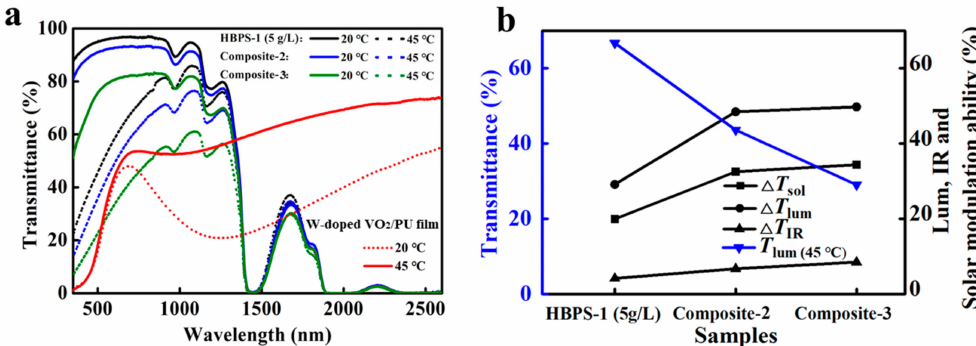
Figure 7. ( a ) UV-vis near-IR spectra of films of W-doped VO 2 (M) / PU with 2-3 µ m thickness (red solid and dashed lines), HBPS-1 (5 g / L), Composite 1 and Composite 2 at 20 and 45 ◦ C; ( b ) Changes of T lum , ∆ T ∆ T ∆ T / L), Composite 2, and Composite 3. sol , IR , and lum for films of HBPS-1 (5 g